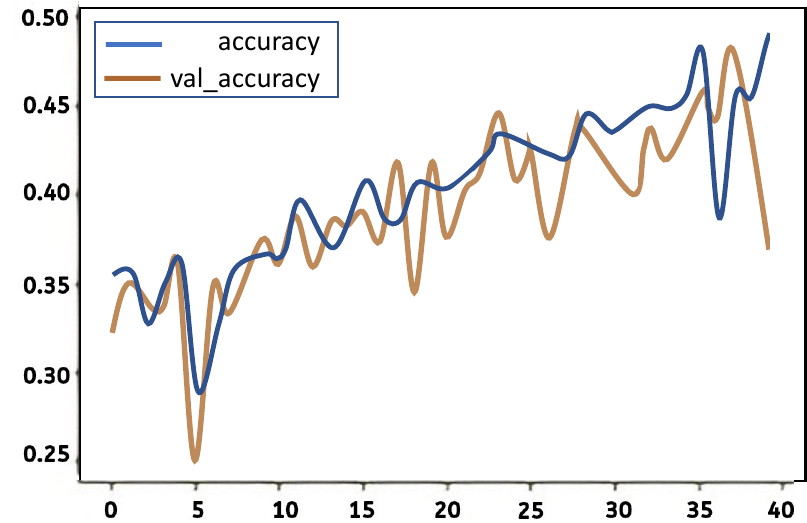
Figure 17. Graph of LSTM model training and testing accuracy against the number of iterations.